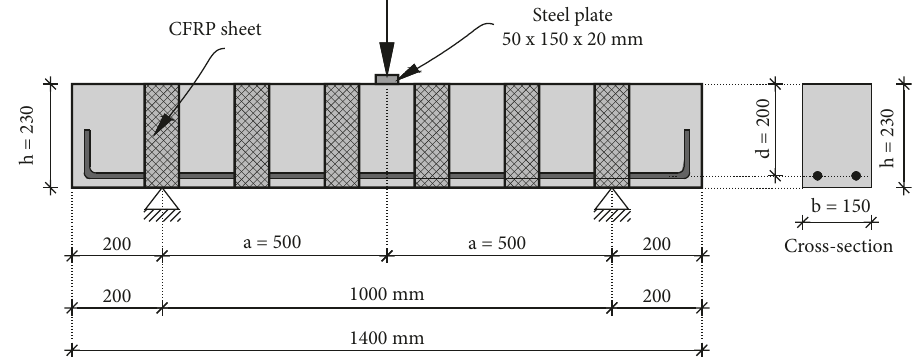
Figure 1: Geometry, reinforcement, and CFRP sheets of beam A2.5RC10/10 [33]. Table 1: Properties of tests beams by Keskin [34]. Longitudinal reinforcement and CFRP sheets Beam f c ( MPa )